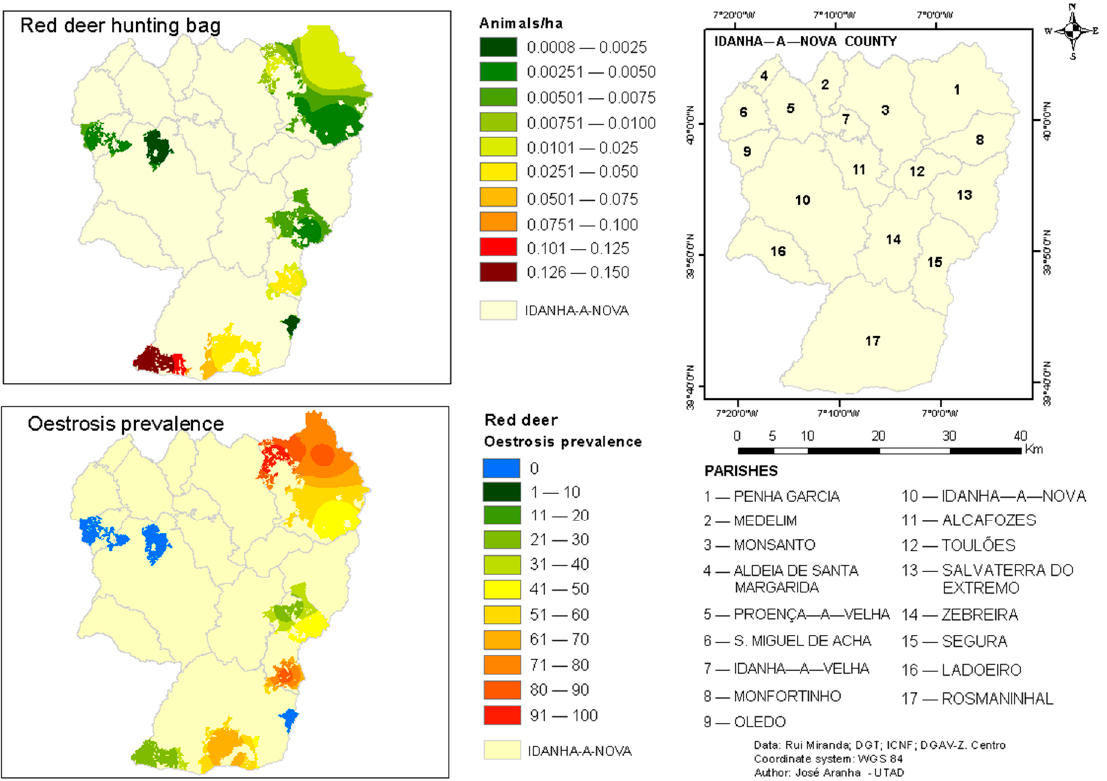
Figure 1. Geographical distribution of Oestrosis prevalence by hunting areas (GIS).